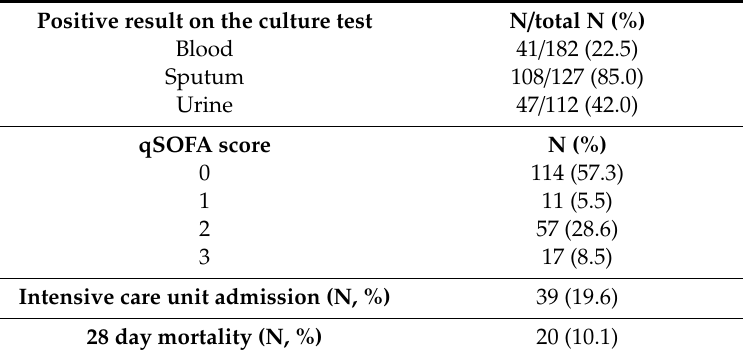
Table 2. Clinical outcome of study participants.